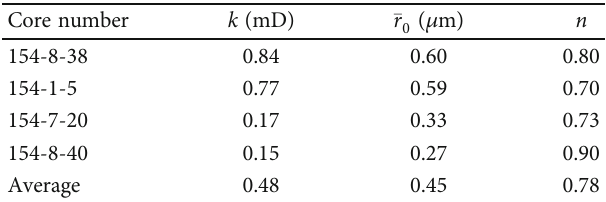
Table 5: Fitting results of experimental core diameter (sandstone